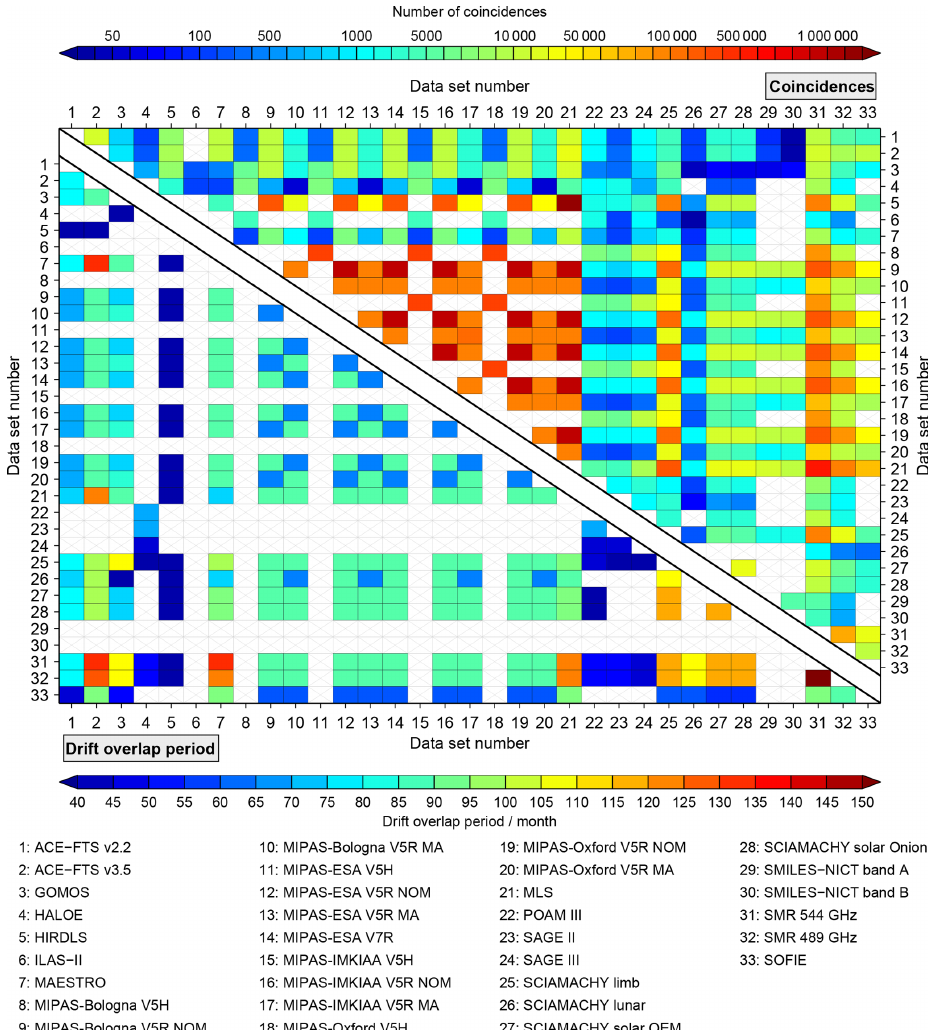
Figure 3. Overview of the number of coincidences (upper triangle) and the drift overlap period (lower triangle) between the compared data sets. All numbers consider the comparisons that take into account coincidences during all seasons and at all latitudes. White boxes with grey crosses indicate that no comparison results are available (either yellow or red in Fig.